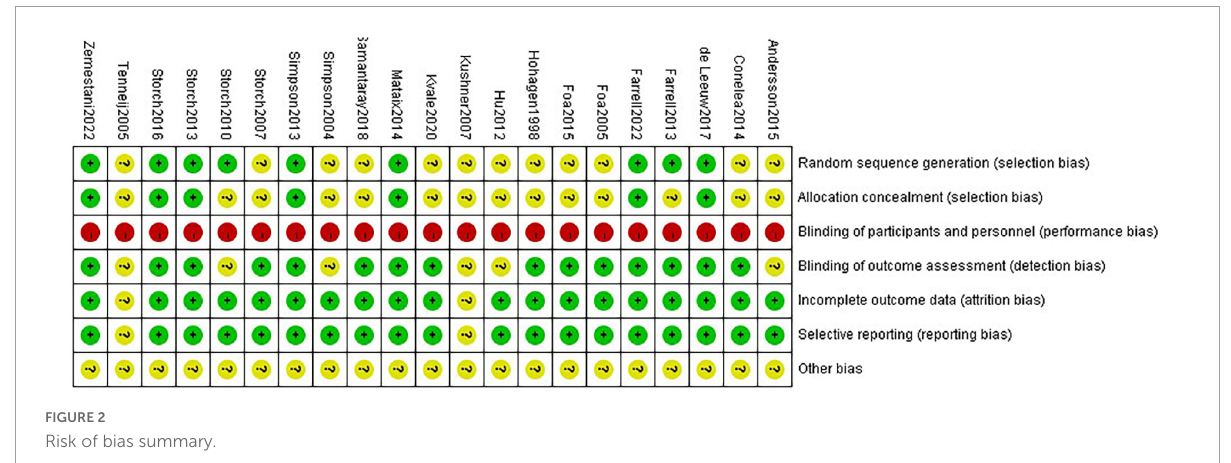
TABLE 1 Basic characteristics of included